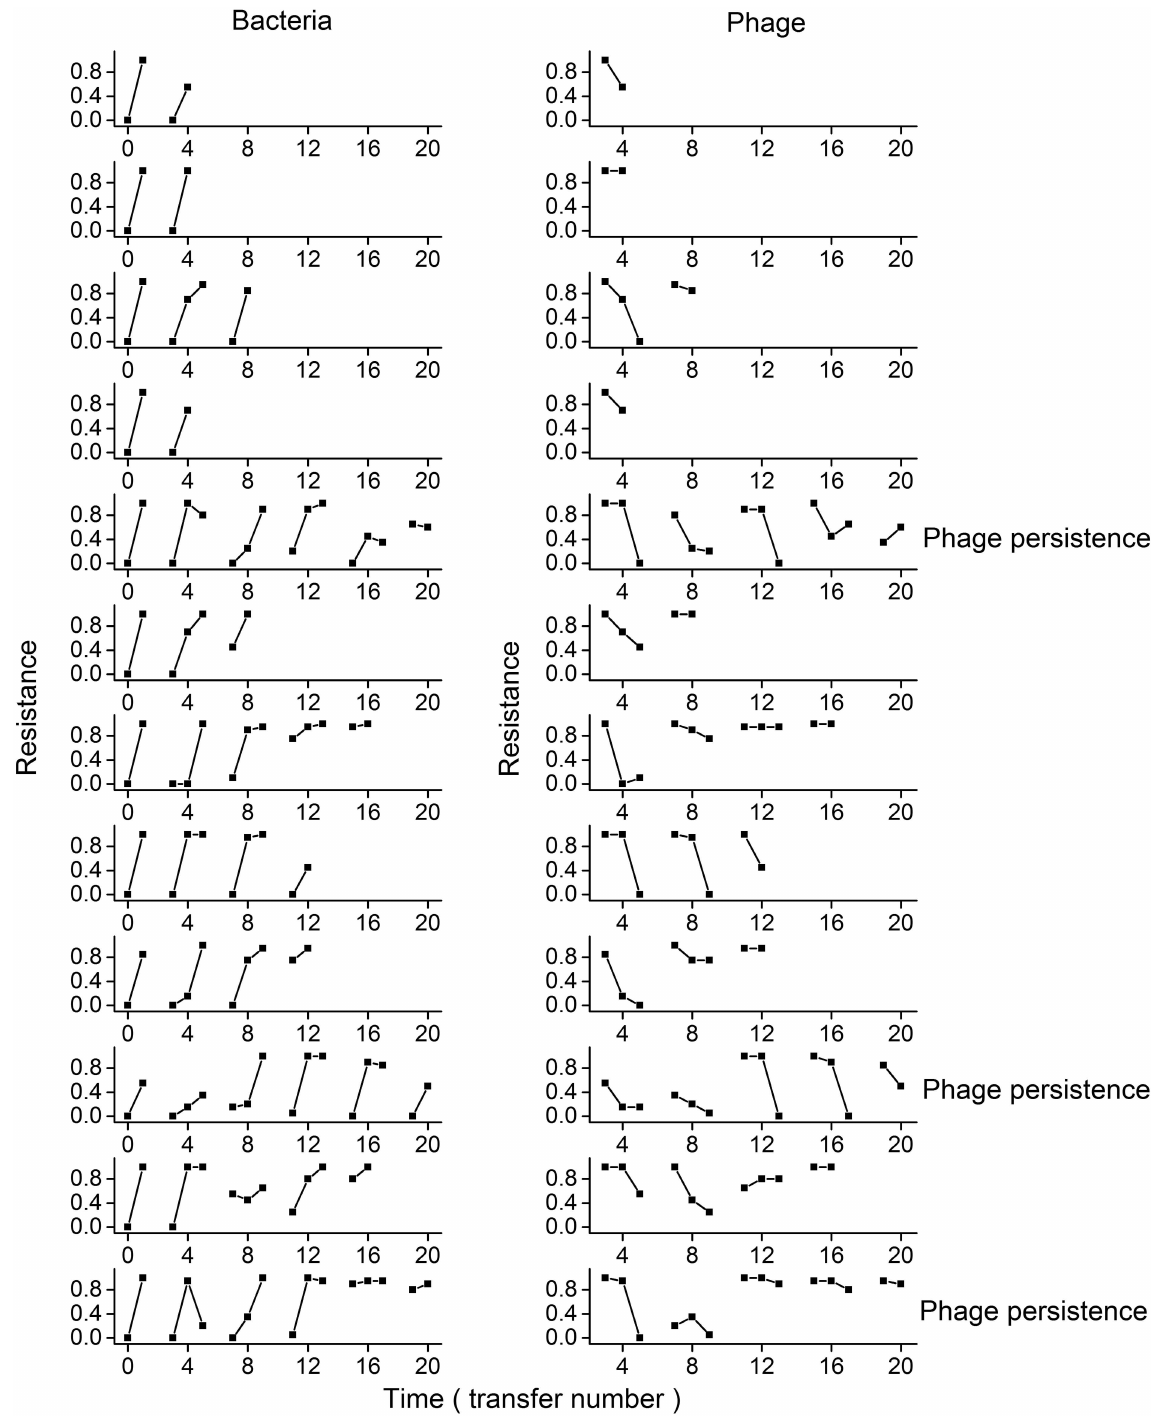
Fig 5. Change in bacterial resistance and phage infection in high-resource microcosms. Symbolsare as in Fig 3.